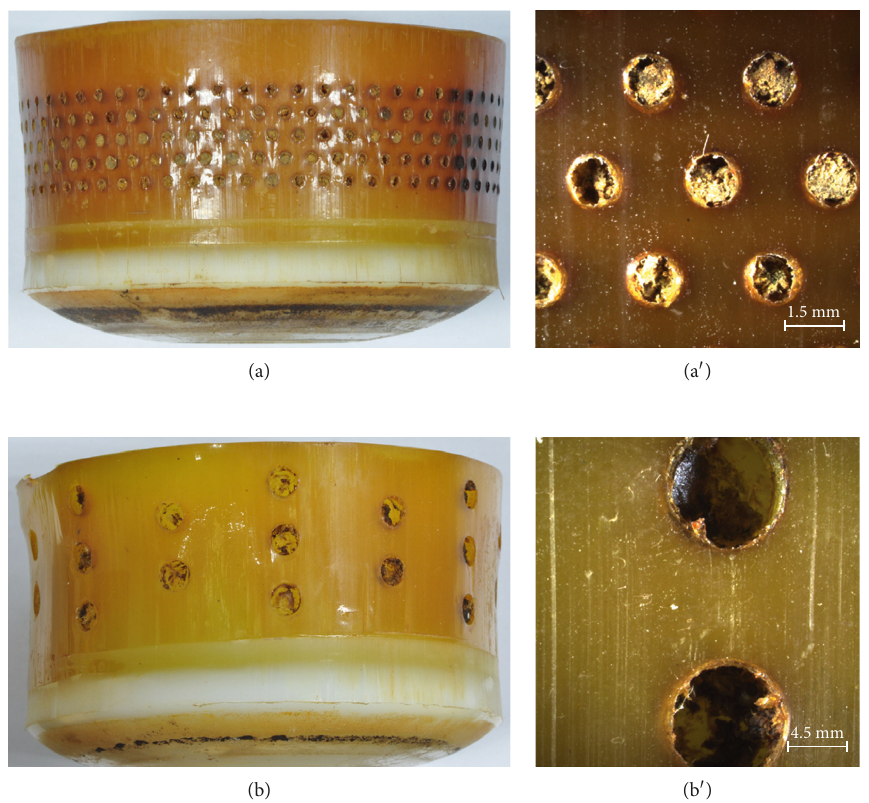
Figure 6: Wear patterns of pistons with different dimple central included angles under the same area density: (a) L-S1 piston and (b) L-S2 piston. (a ′ , b ′ ) were partial enlarged pictures of (a,